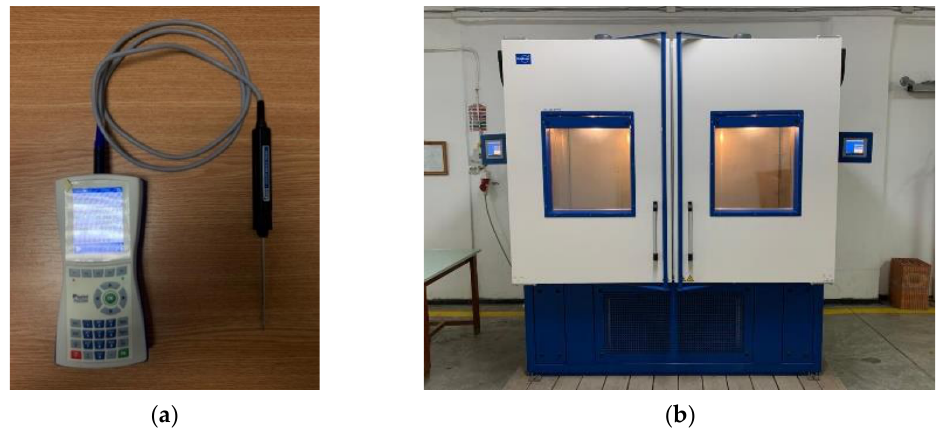
Figure 1. ( a ) Heat transfer analyzer; ( b ) twin test climate chamber.